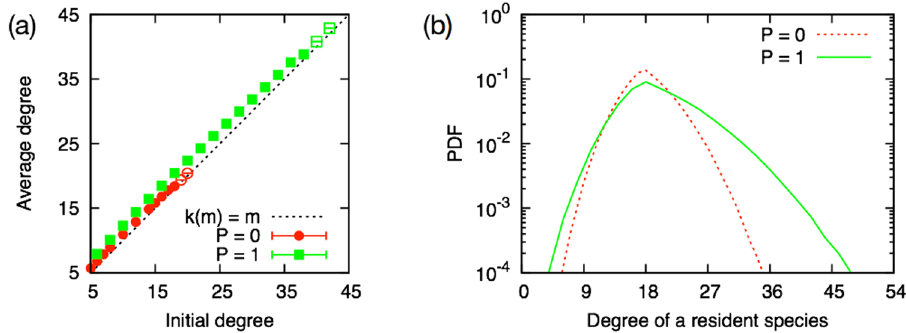
Figure 6. ( a ) Average degree of the emergent system. The emergent system in the bidirectional model (boxes) has larger average degree than that of the unidirectional model (circles) with the same unidirectional link degree of the new species m P = 0 = 2 M P = 1 . ( b ) Degree distribution of the emergent system at m = 18. The degree distribution of the bidirectional model (solid line) has broader tails than that of the unidirectional model (dashed line), with sharing the same peak